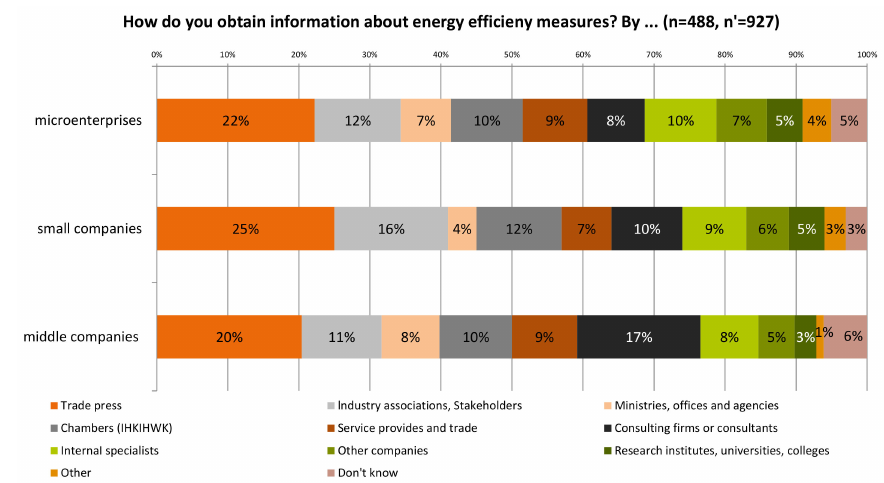
Figure 9. Information sources about energy e ffi ciency measures.